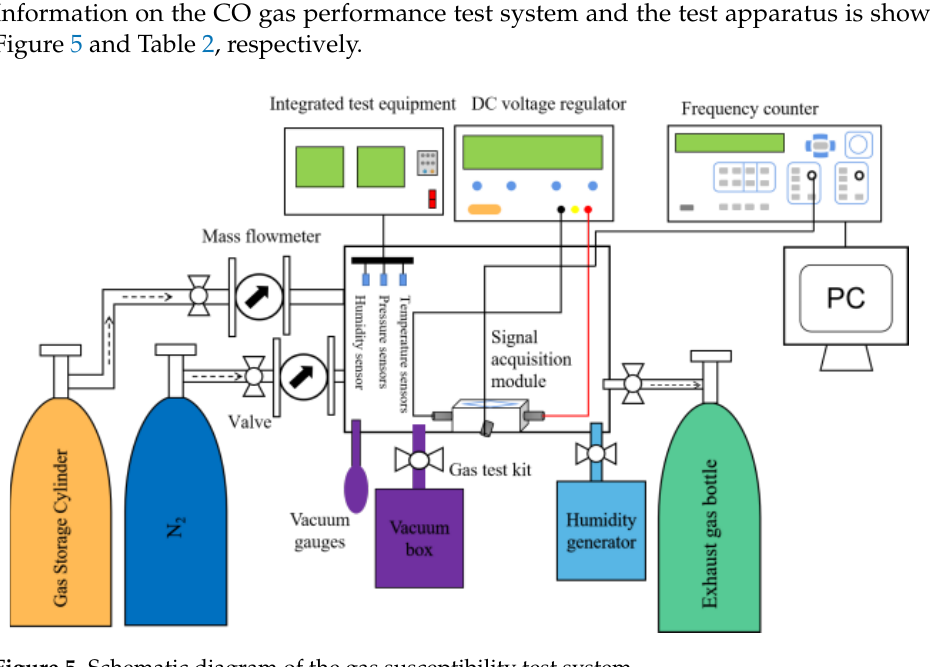
Figure 5. Schematic diagram of the gas susceptibility test system. Table 2. Information sheet on the instruments used in the SAW sensor gas sensing test system.